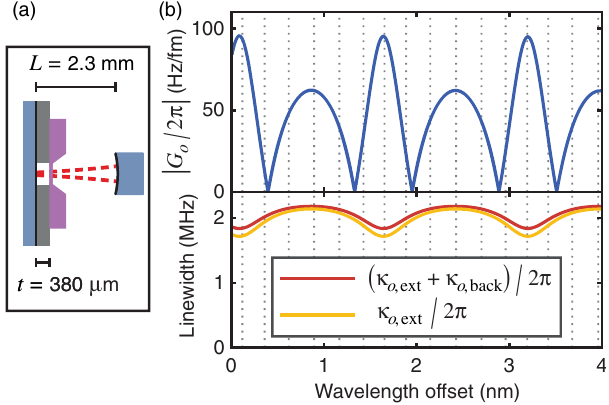
FIG. 7. Optical cavity simulation. (a) Optical cavity length scales. (b) Simulated optomechanical cavity parameters. The free spectral range associated with the t ¼ 380 μ m spacing between the membrane and mirror chip sets the periodicity of the optical frequency shift per membrane displacement G (top) and cavity o mirror loss rates κ and κ (bottom) that would be obtained o; ext o; back if the optical cavity had a piezoelectrically actuated curved mirror. Gray dotted lines indicate operating parameters available to a cavity without piezoelectric actuation like the one used in this